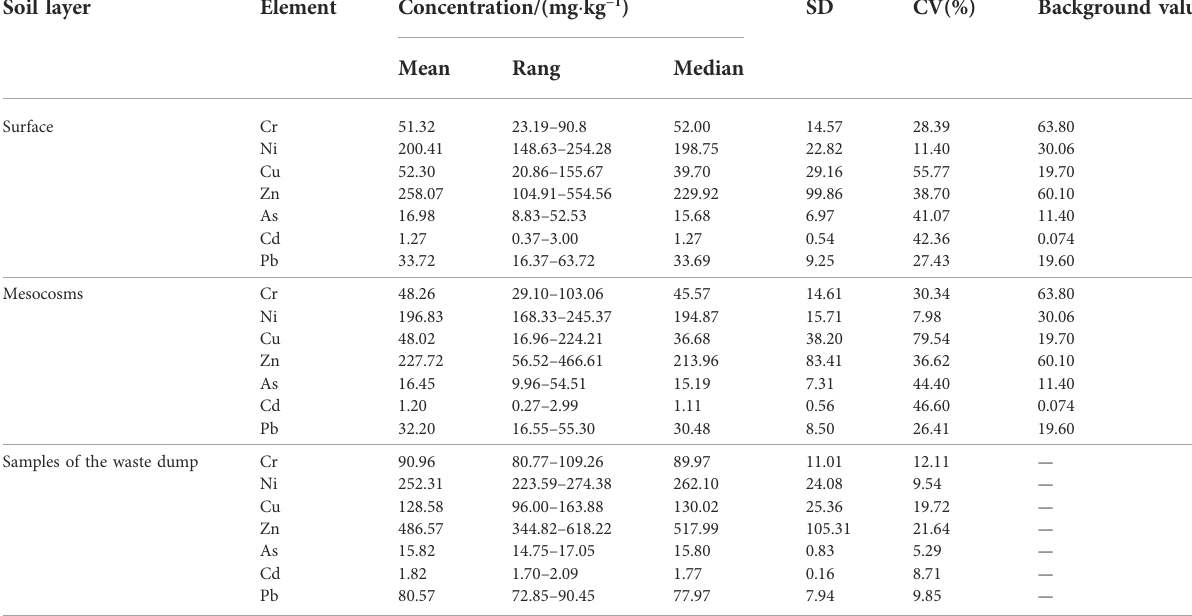
TABLE 6 Statistical results of heavy metals content in farmland soil and the waste dump samples in the study area. Soil